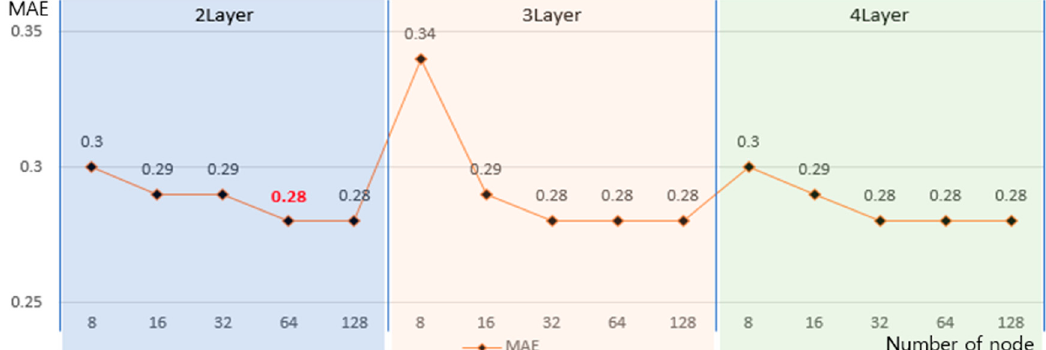
Figure 5. Experimental results for optimization of the Deep Neural Network (DNN) model.